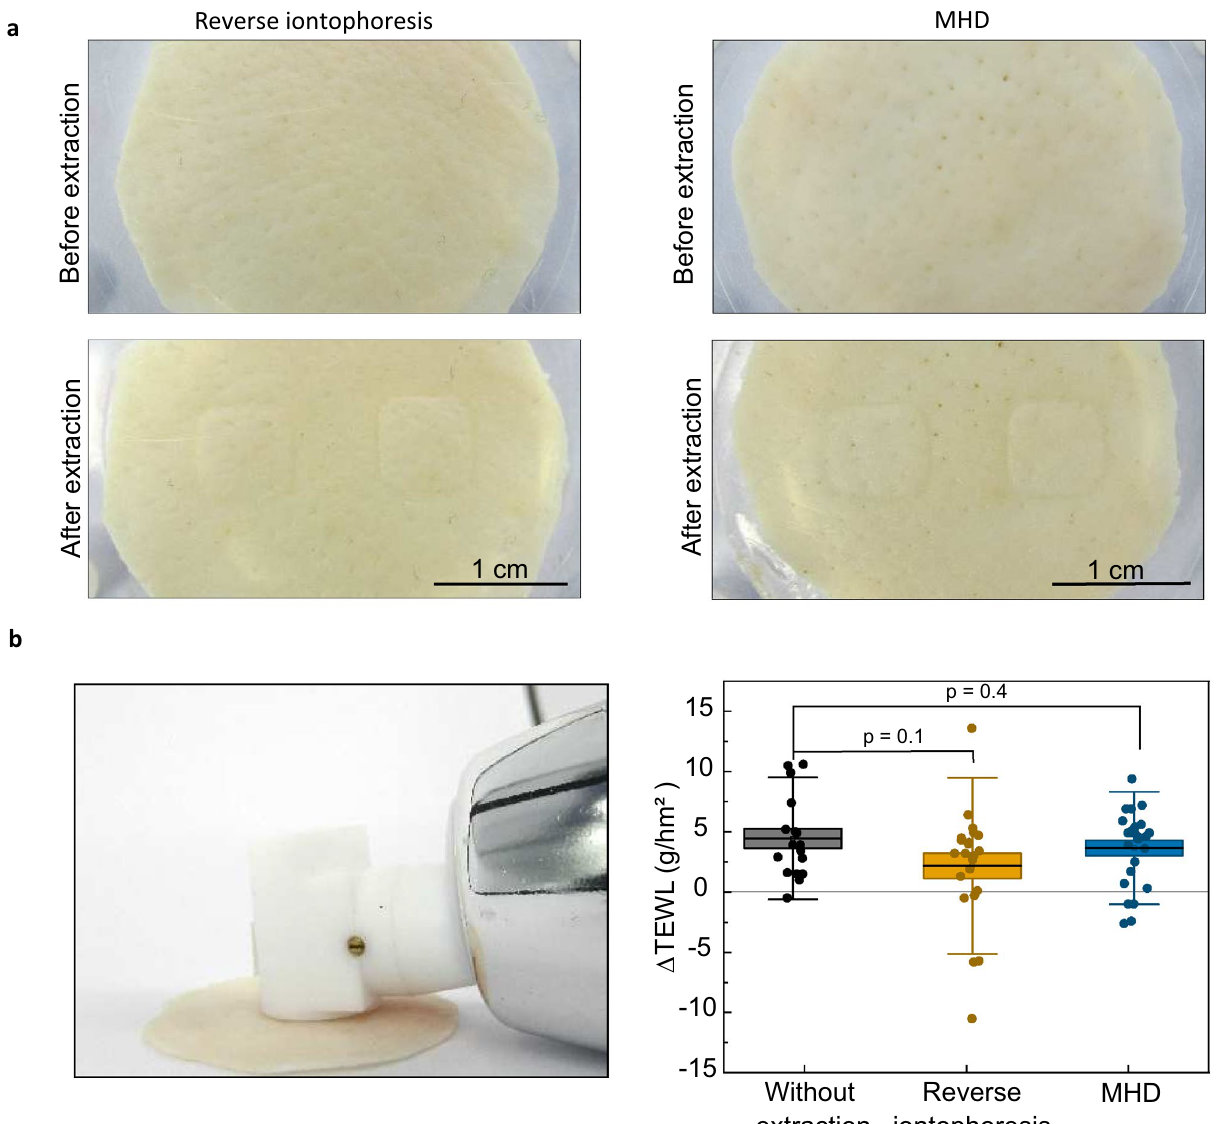
Figure 4. ( a ) Photographs of porcine skin samples used in this study either with reverse iontophoresis or MHD. No damage apart from minor imprints from the electrode wells were visible. ( b ) Skin water loss was measured at room temperature using a Tewameter before and after extraction (delta = after extraction-before extraction). The Tewameter readings measured after reverse iontophoresis (n = 22) and extraction with MHD (n = 23) were not statistically different from the values measured for samples where no active extraction was applied (n = 17). Individual data points are represented with circles and the boxes behind the data points represent the standard error. The thin, horizontal lines mark the mean values, and the error bars depict standard deviation of the dataset. The p-values were calculated using an unpaired